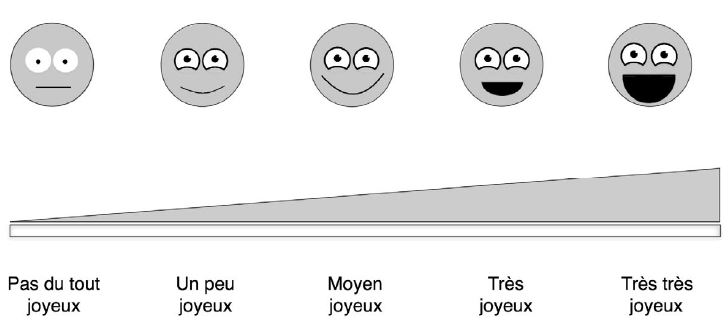
Figure A1. Joy subscale of the Youth Emotional Self-Report Scale.